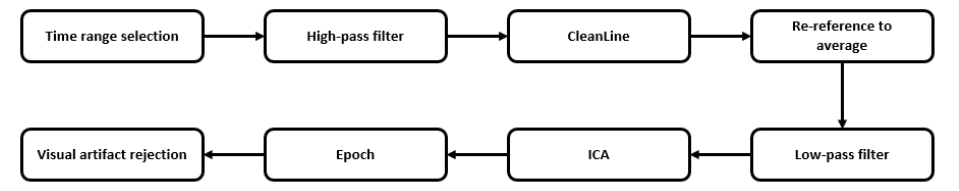
Figure 1. Preprocessing